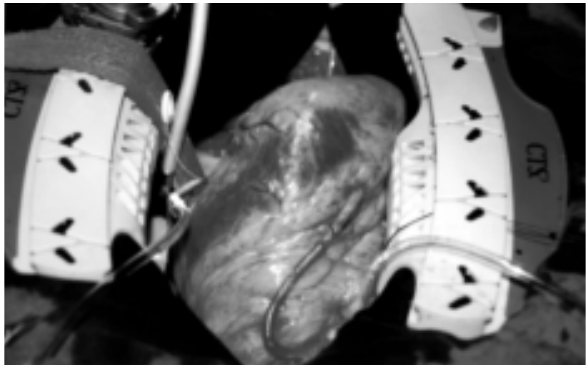
Fig. 1 – Posicionamento do coração para acesso dos ramos